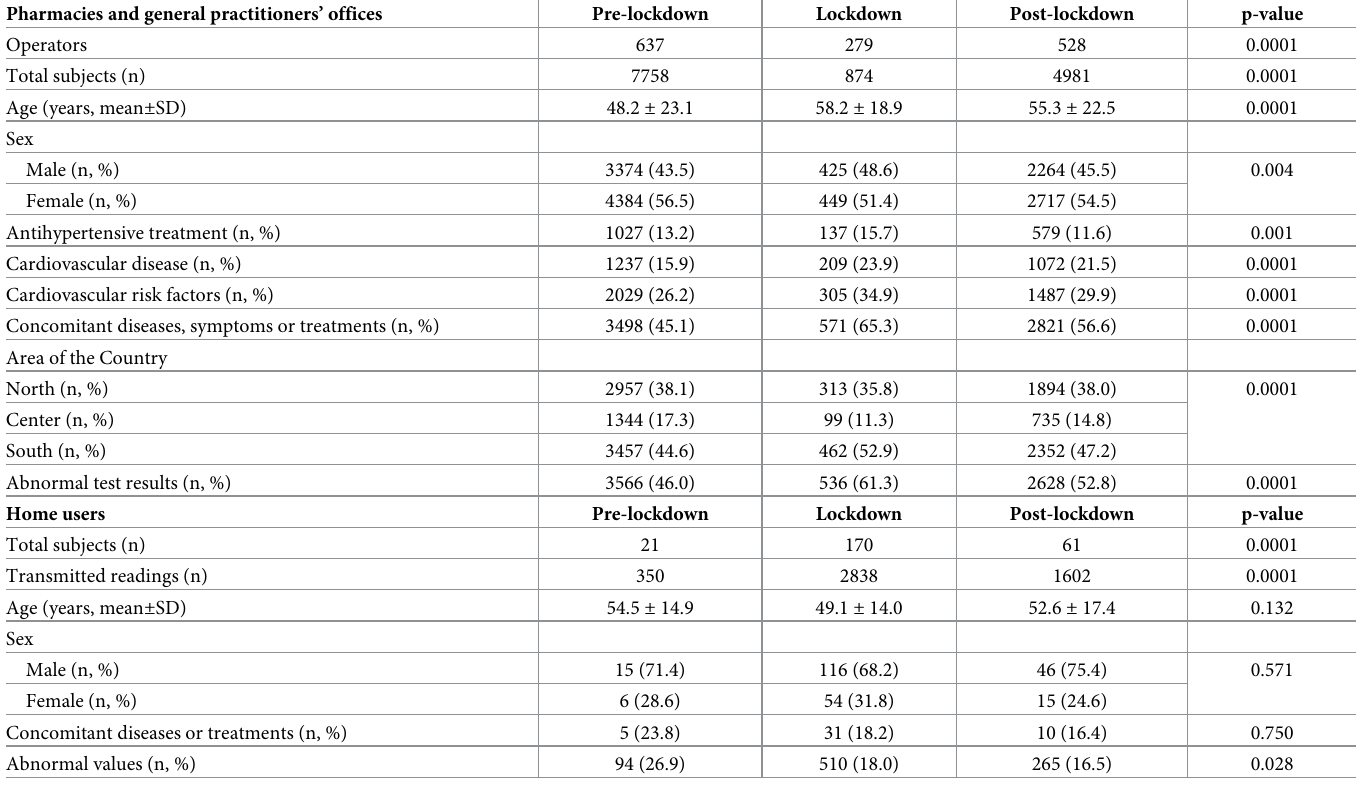
Table 1. General characteristics of subjects and tests performed in the community during the COVID-19